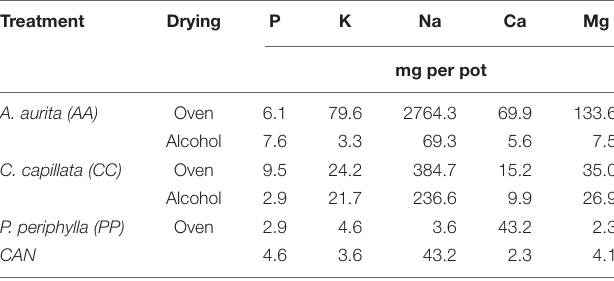
TABLE 2 | Nutrients applied per pot in each treatment according to the controlled fertilization rate of 58.4 mg N per pot (50 kg N ha − 1 ).